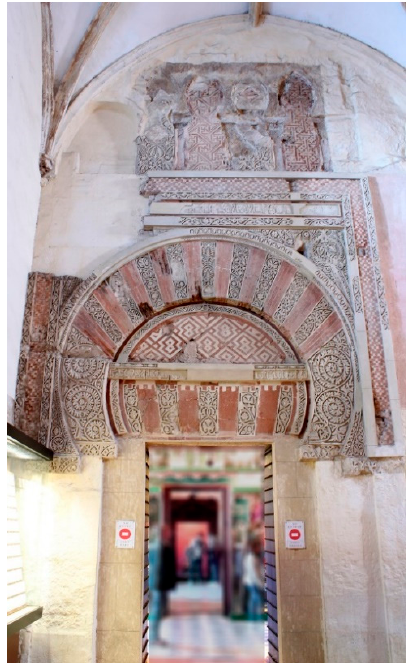
Figure 12. Great Mosque of Cordoba. Eastern door of the al- Ḥ akam II’s enlargement, called “del Punto” and located next to the qibla wall. © Photo took by author.